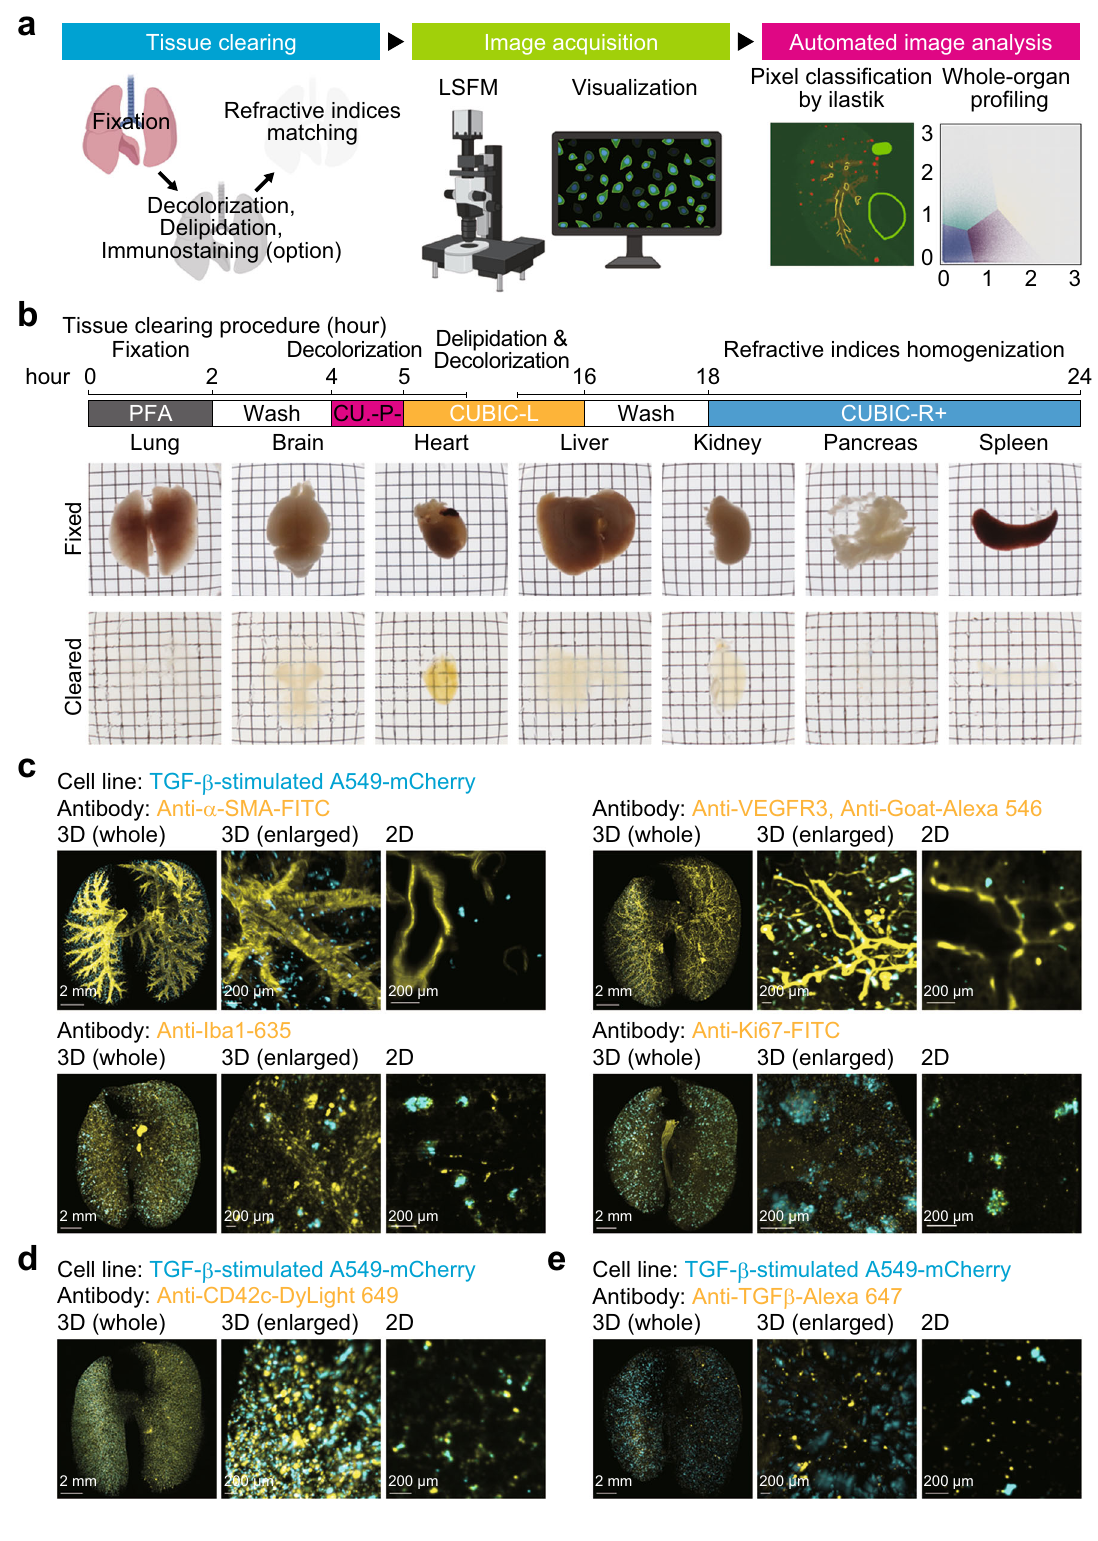
the metastatic colonization of cancer cells through the induction of EMT 19 . To examine whether TGF- β -stimulated cancer cells affect metastasis of other cancer cells within the tumour micro- environment in vivo, both TGF- β -stimulated and unstimulated cancer populations were mixed at various ratios and injected into mice. To distinguish the two cancer populations, prestimulated and unstimulated cancer cells were labelled with different